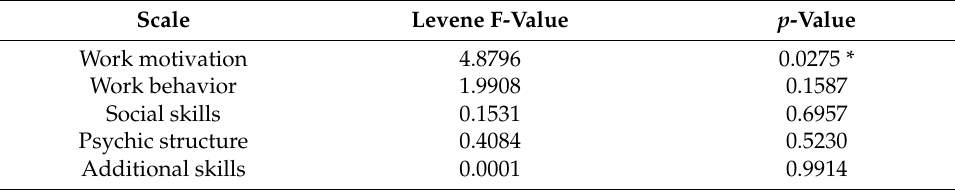
Table 6. Levene test statistics when the sample is differentiated by